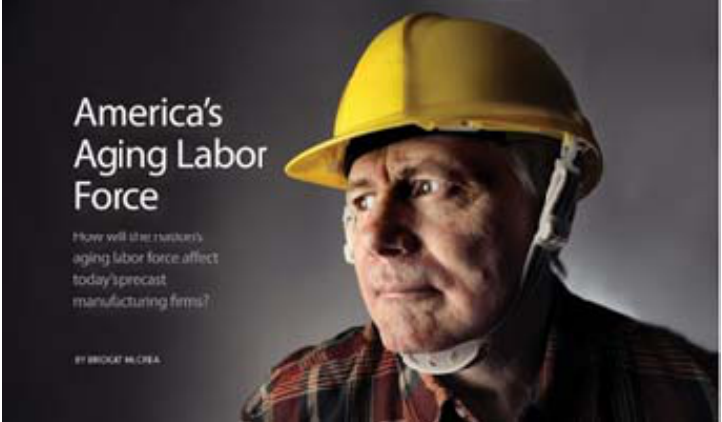
Figure 5. Online Article: America’s Aging Labor Force.